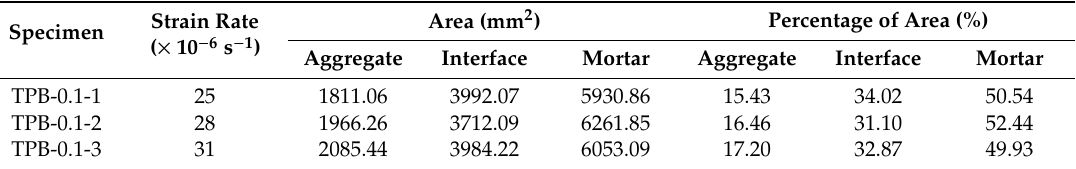
Table 3. Component area and the corresponding percentages under static loading.